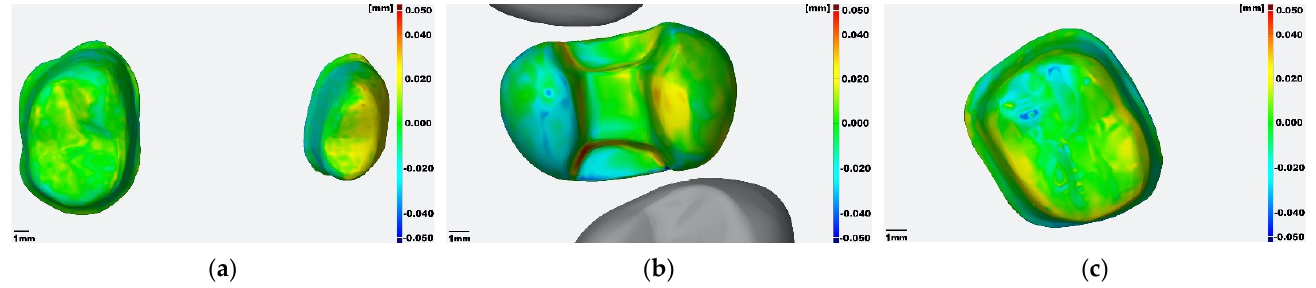
Figure 3. Local trueness evaluation via surface comparison: printed against reference: ( a ) [local_PRINT 17-15 ;]; ( b ) [local_PRINT 24 ]; ( c ) [local_PRINT 26 ] [Scale ± 50 µm].